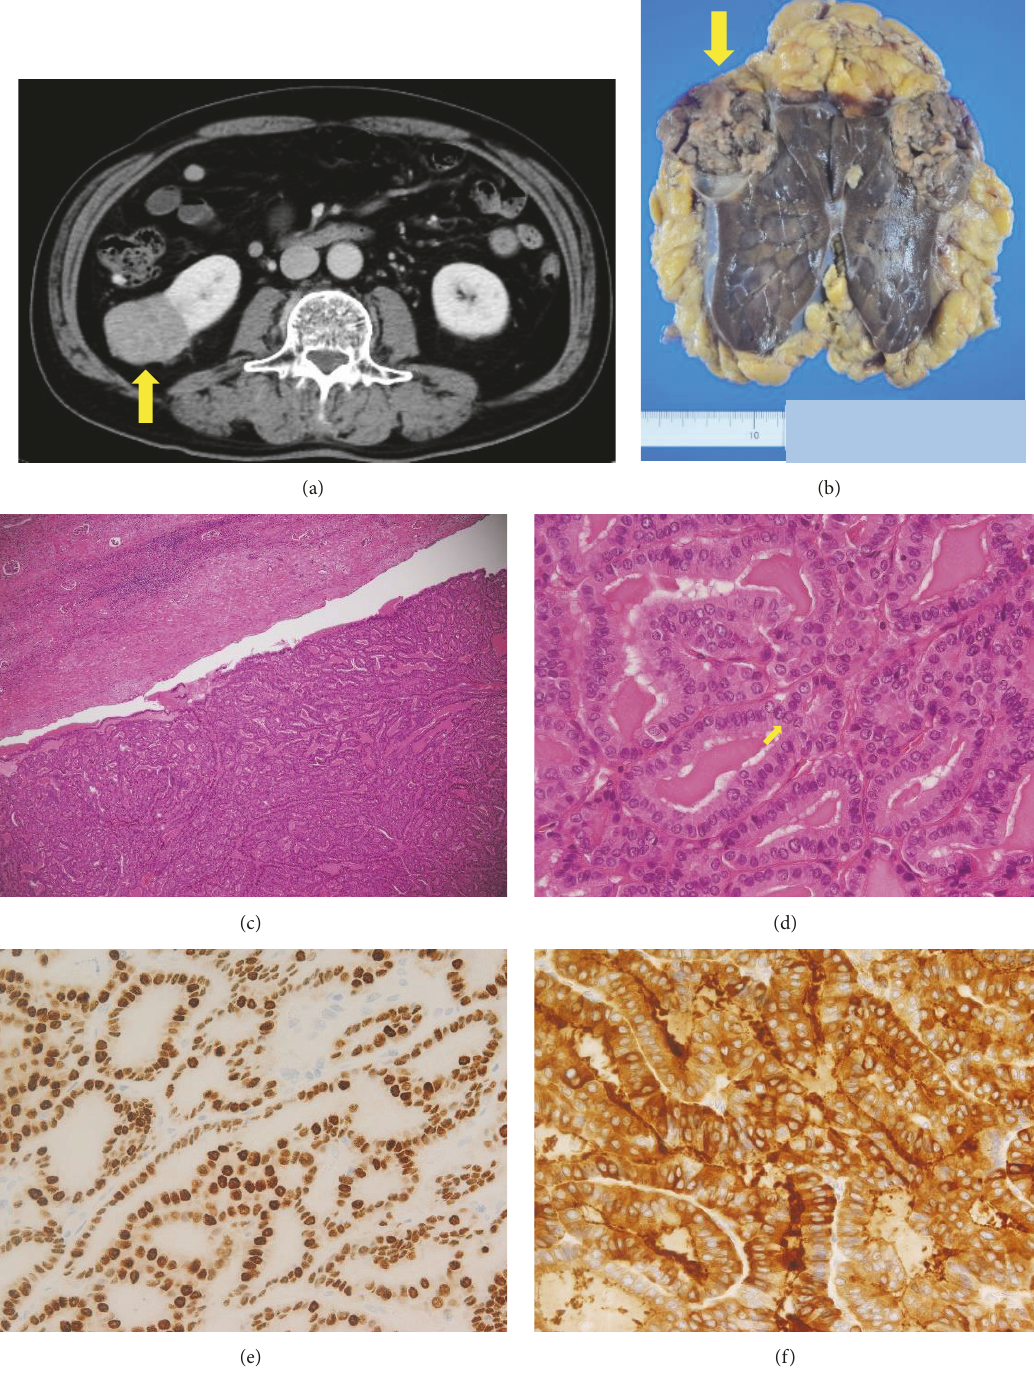
Figure 1: (a) Computed tomography showed the right kidney tumor (arrow). (b) The right nephrectomyspecimen contained a grayish tumor measuring 5.5cm × 5.0cm on the upper pole (arrow). (c, d) Histologic sections of the resection specimen showed that the tumor formed a papillary structure, and the lumen was filled with eosinophilic substances considered colloids. Individual cancer cells had nuclear grooves, and findings suggestive of nuclear inclusions were also observed (arrow). (c): Original magnification x200, (d): Original magnification x400. (e, f) Immunohistochemistry revealed positive for thyroid transcription factor 1 (e) and thyroglobulin (f). Original magnification